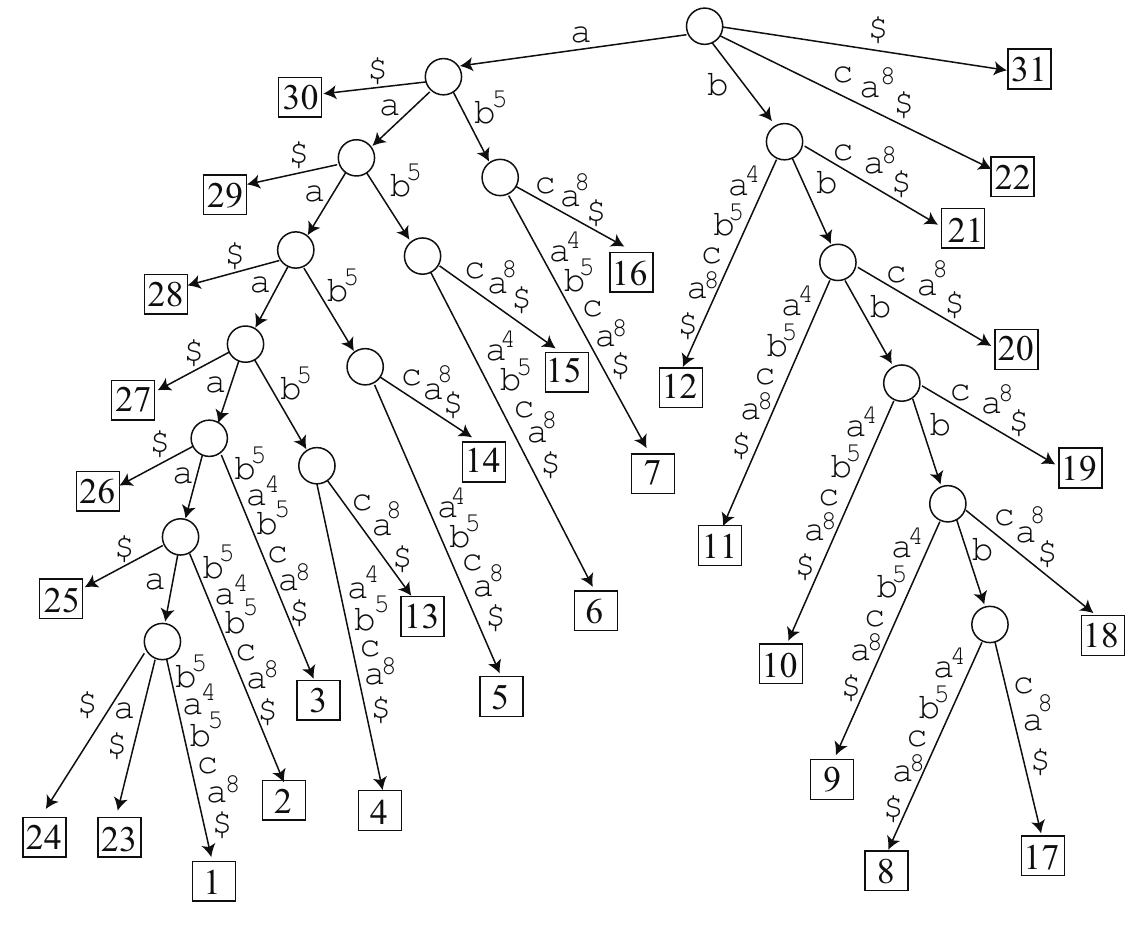
Figure 8. STree ( w ) with w = aaaaaaabbbbbaaaabbbbbcaaaaaaaa $